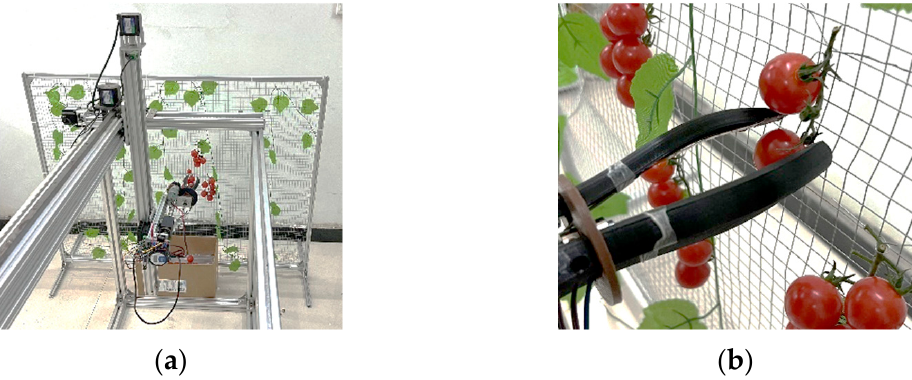
Figure 15. Experiment of cherry tomatoes picking: ( a ) The system of picking robot; ( b ) Gripper picking.